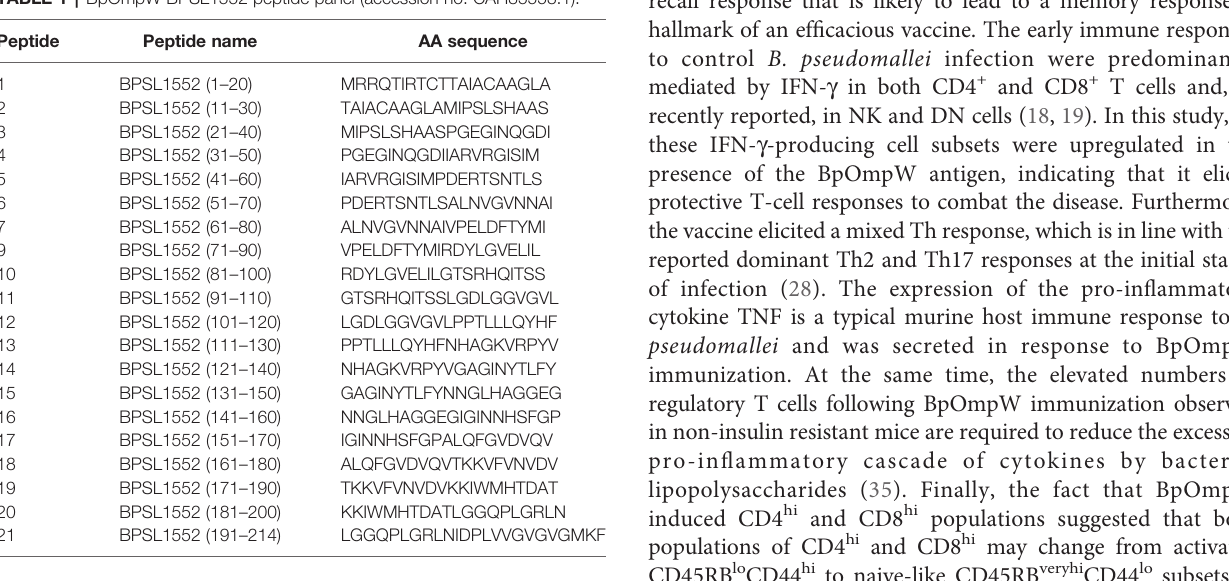
TABLE 1 | BpOmpW BPSL1552 peptide panel (accession no. CAH35553.1).